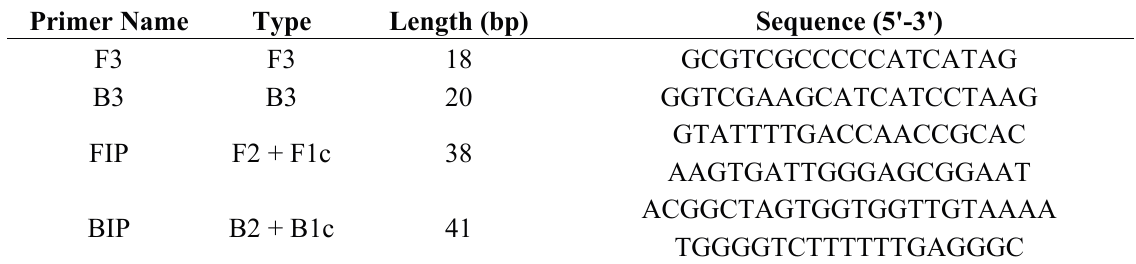
Table 1. LAMP primer used in this